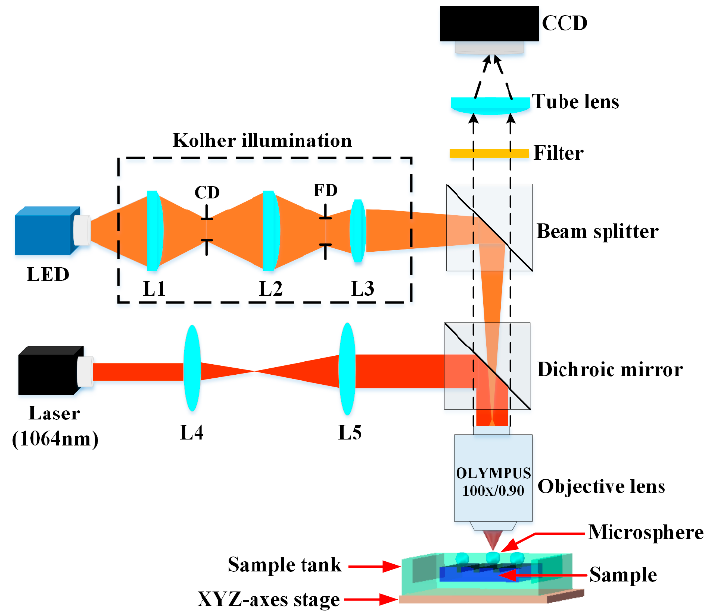
Figure 3. Schematic of the constructed optical system. The red path represents the optical trapping system and the tangerine path serves as the imaging part. The same objective lens is used for both the trapping process and the observation.